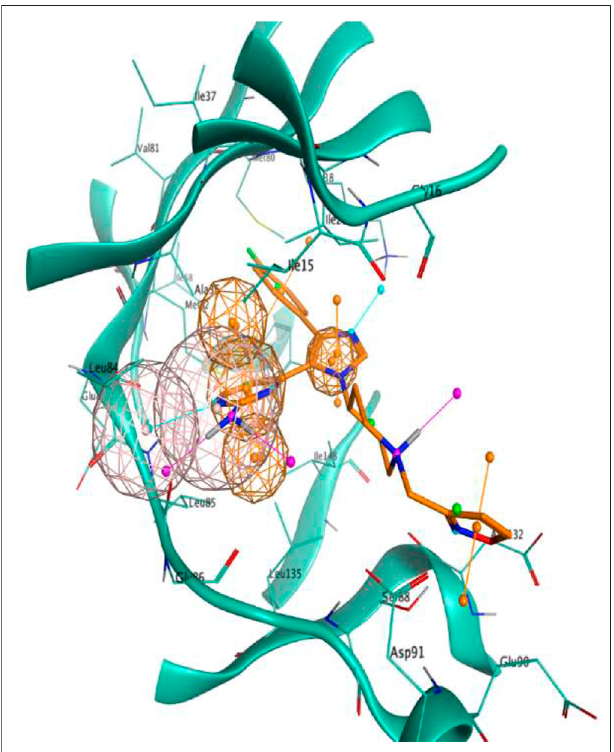
FIGURE 1 | Visual representation of the pharmacophore model used in this scienti fi c work. Features are represented as spheres. Orange spheres indicate an aromatic ring, with an orientation determined by the small orange pin, while the pink spheres indicate a hydrogen bond donor/acceptor. For visual reference, the 4TN6 complex is also reported in this fi gure, with the protein represented in teal ribbons and the PFO ligand represented as orange